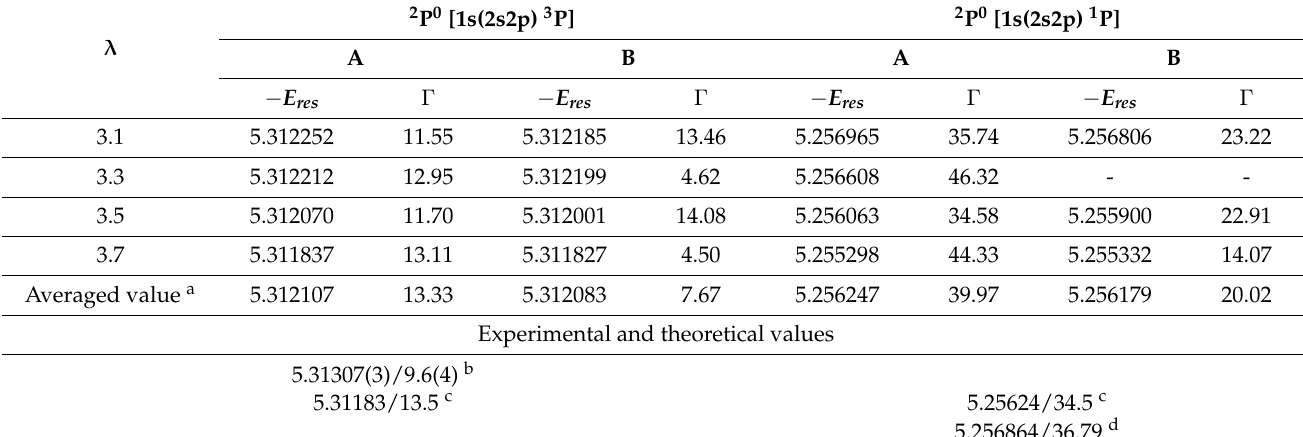
Table 5. Energy (a.u.) and width ( × 10 − 5 a.u.) of the first and the second 2 P 0 resonant states of Li atom.